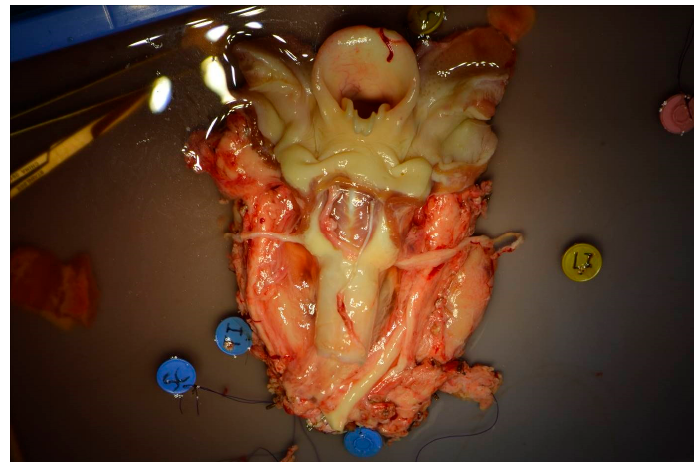
Figure 1. The transplant was completely harvested by performing the equivalent of a total circular pharyngolaryngectomy, including about 10 trachea rings and the entire visceral, vascular and nerv- ous axis.